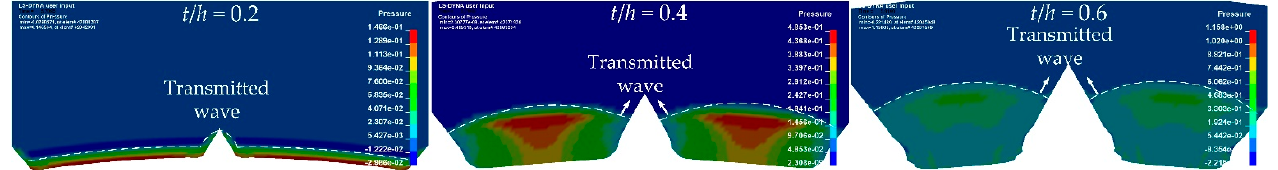
Figure 10. Relationship between t / h and SCFs at groove tips.